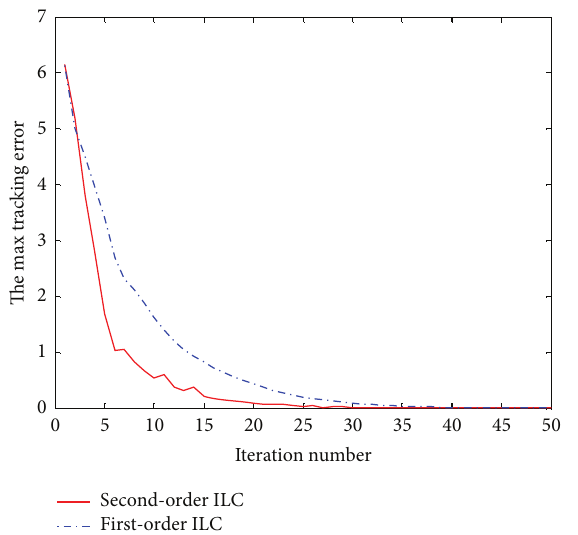
Figure5:ThemaxtrackingerrorofExample1fordifferentILClaws.